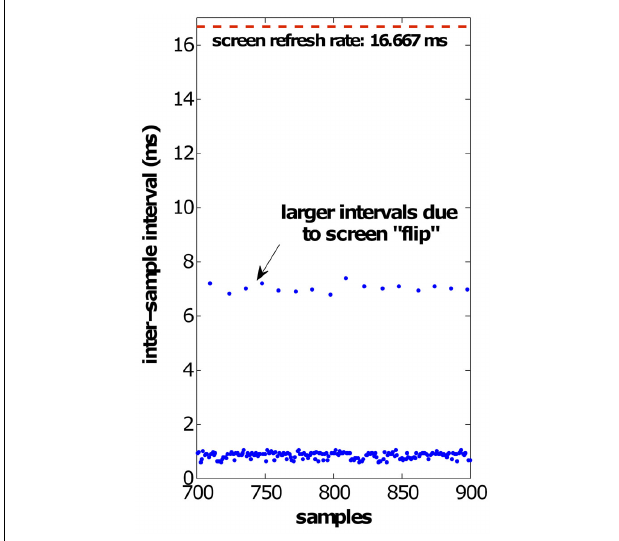
FIGURE 5 | Input data sample intervals. Sample intervals are about 7ms when the Psychtoolbox function flip puts the data in the video buffer on the screen.To achieve a sample rate greater than 1kHz, inter-refresh sample rates are generally smaller than